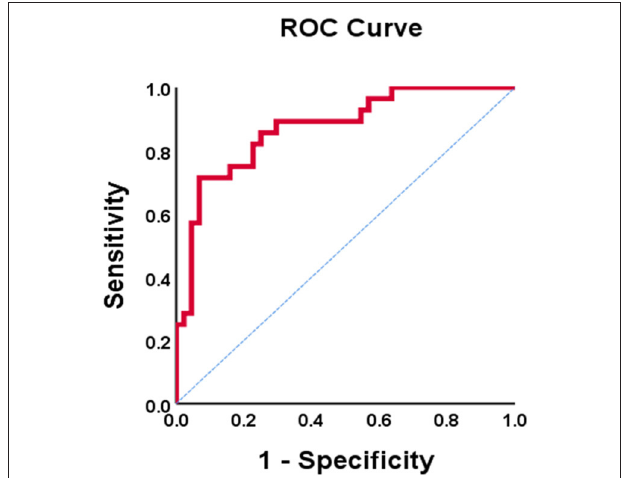
FIGURE 1 | ROC curve of PP combined Ea diagnosis AMS. AMS, acute mountain sickness; PP, pulse pressure; Ea, effective arterial